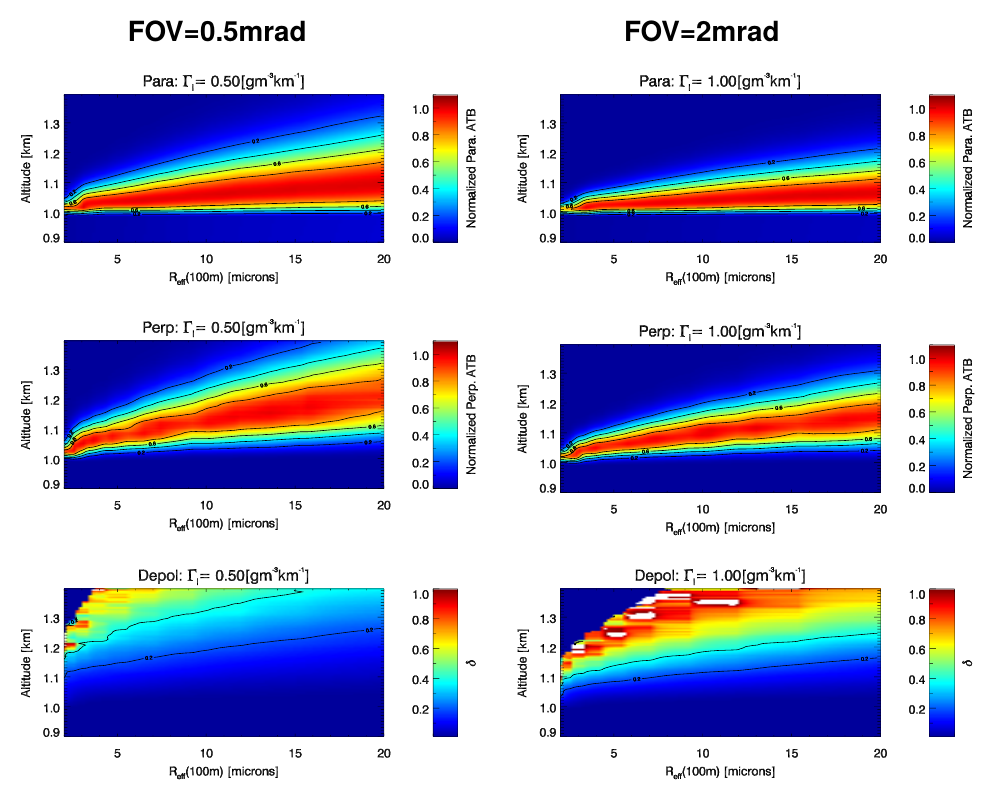
Figure 3. Example results of MC calculations for a lidar wavelength of 355nm corresponding to semi-infinite clouds with a cloud-base of 1.0km for two values of (cid:48) l as a function of R eff,100 for lidar FOVs of 0.5 and 2.0mrad. Here, for each value of R eff,100 , the para and perp attenuated backscatter (ATB) values have been normalised by the maximum para